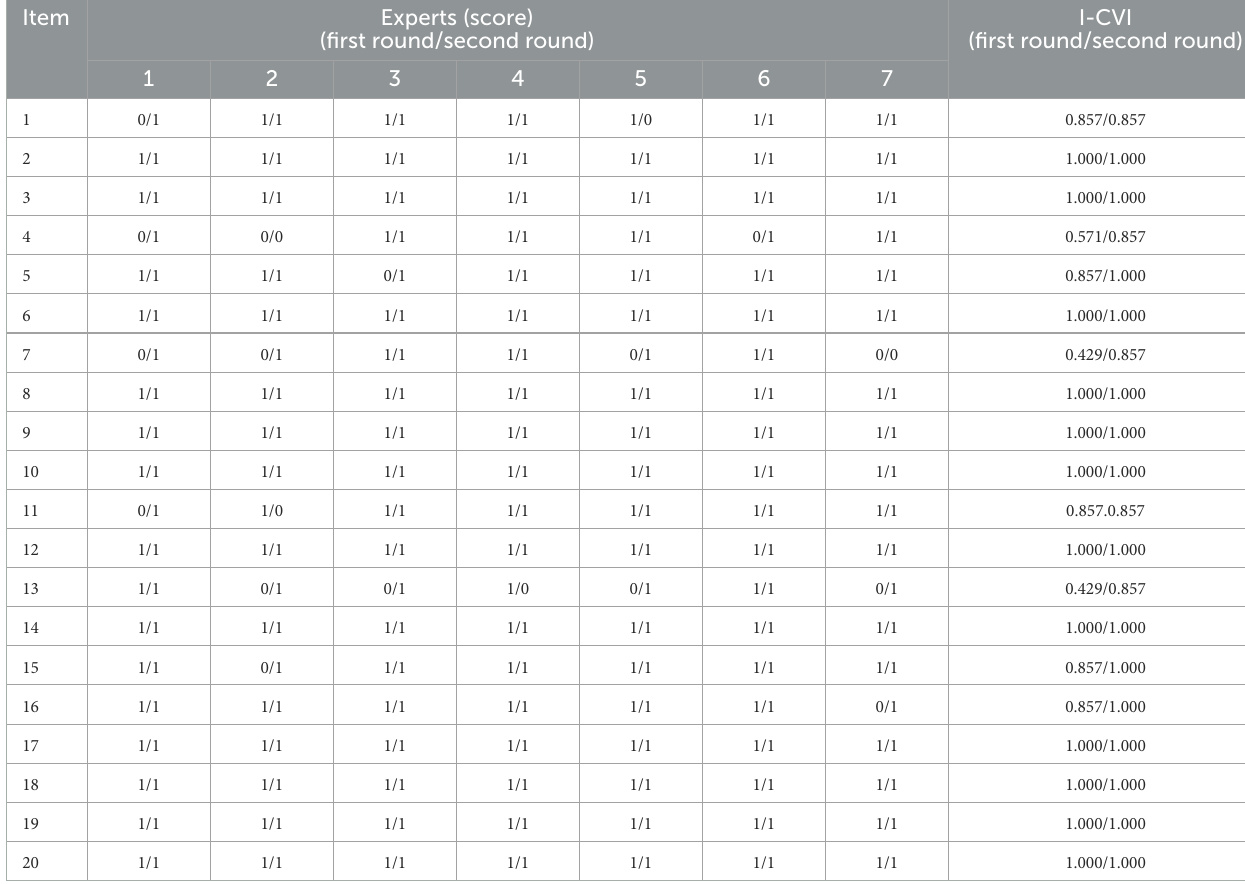
TABLE 2 Content validity analysis for Chinese DoCCA